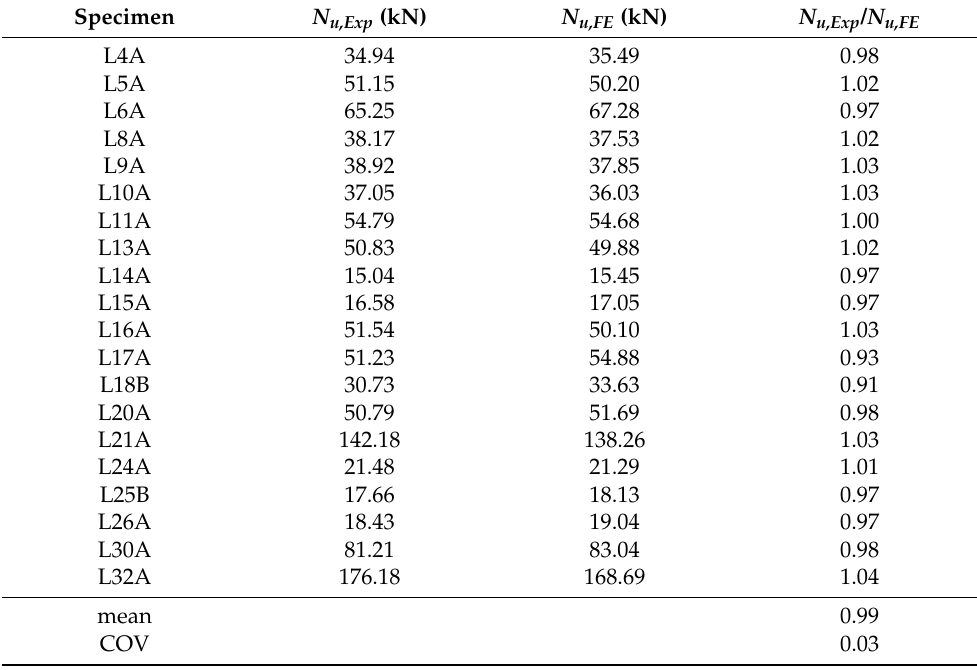
Table 2. Comparison between experimental [3] and numerical ultimate